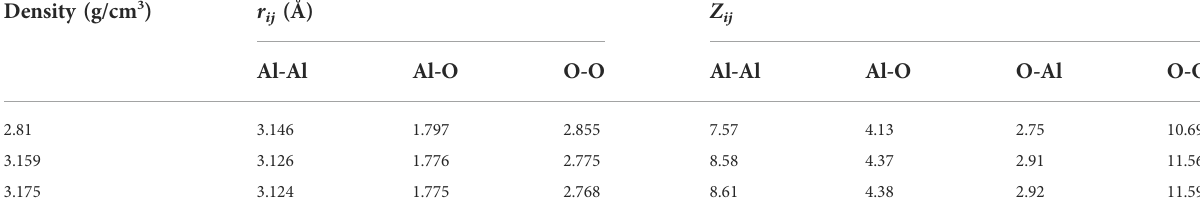
TABLE 3 Structural characteristics of amorphous alumina at 300 K and three densities. r ij -positions of the fi rst peaks in partial pair distribution functions; Z ij -the average coordination number. Density (g/cm 3 )